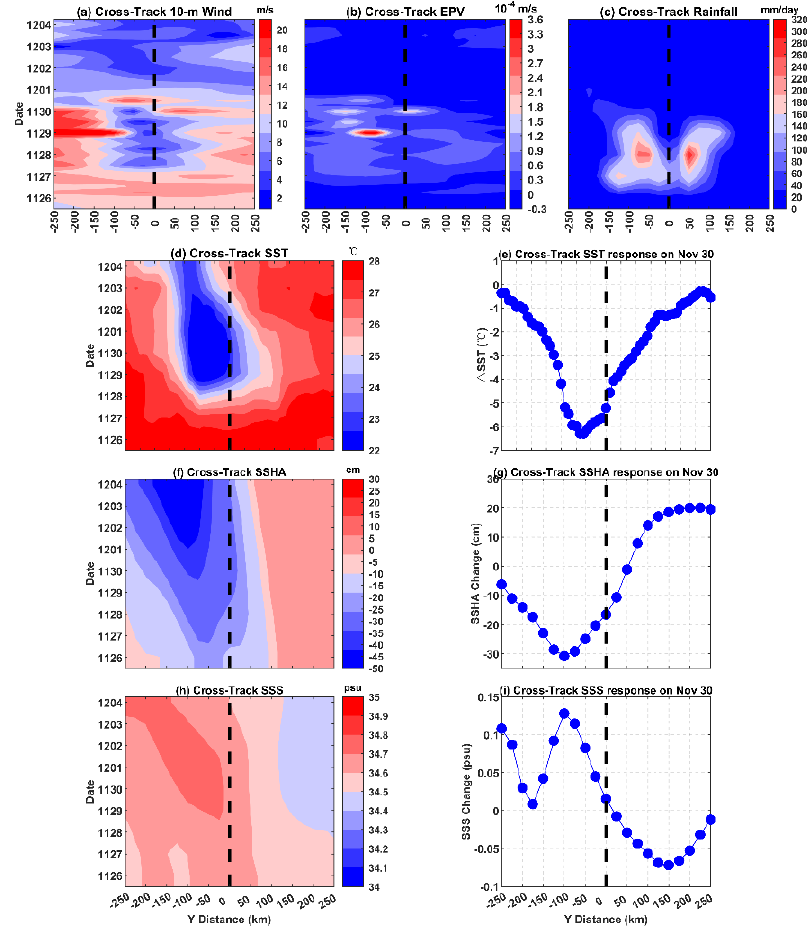
Figure 4. Temporal evolution of cross-track ( a ) SSW (shaded, m s − 1 ), ( b ) cumulative Ekman pumping (shaded, m), and ( c ) cumulative rainfall (shaded, mm) at location 2 during the passage of typhoon Nida (30 November – 4 December 2009). ( d , e ) Temporal evolution of cross-track SST (shaded, °C) and the cross-track SST response on 30 November. ( f , g ) Temporal evolution of cross-track SSHAs (shaded, cm) and the cross-track SSHA response on 30 November. ( h , i ) Temporal evolution of cross-track SSS (shaded, psu) and the cross-track SSS response on 30 November.